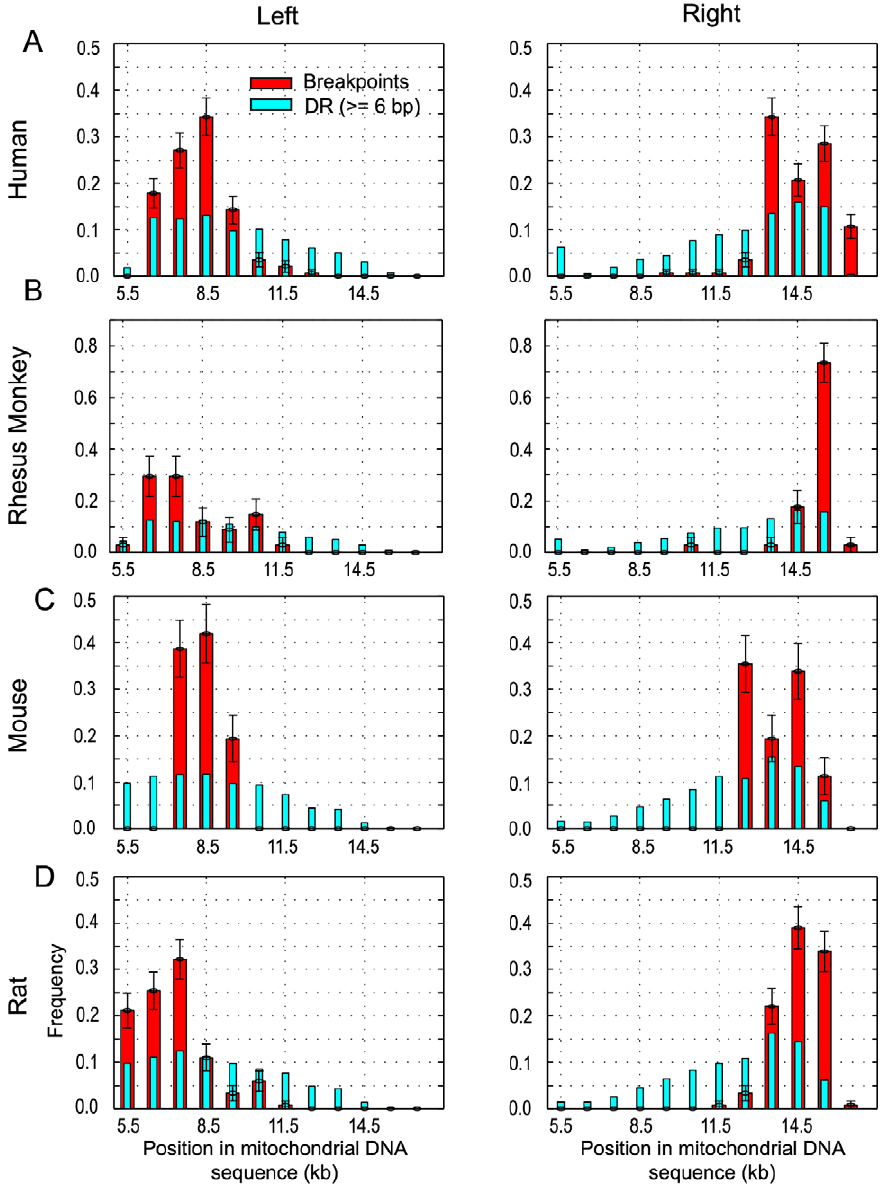
Figure 3. Deletion breakpoints and direct repeats. Distributions of left and right breakpoints of aging-associated mtDNA deletions and of left and right DR motifs from (A) human, (B) rhesus monkey, (C) mouse and (D) rat. Standard deviation (error bars) for the frequency of breakpoints in each bin is calculated based on a binomial distribution.